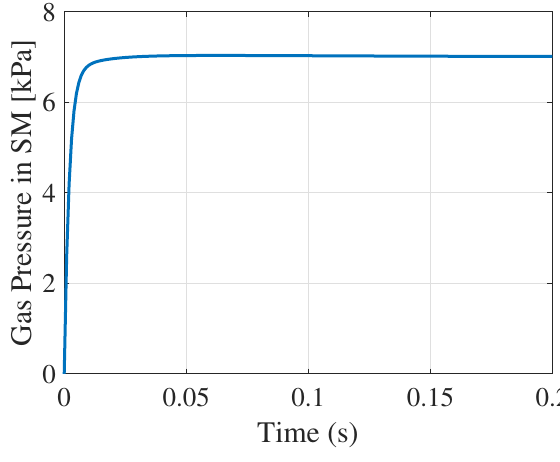
Figure 5. LQR simulation results for p sm .